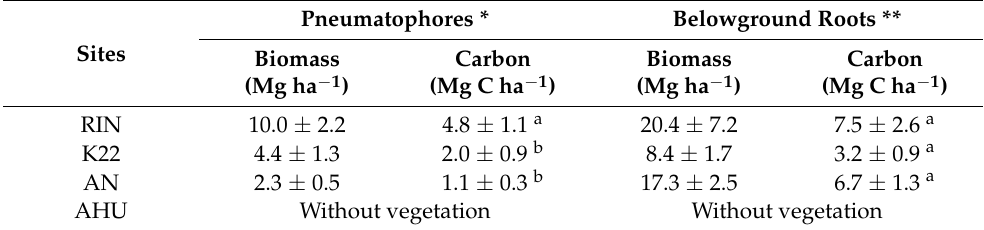
* Plots of 25 × 25 cm. RIN: N = 5. K22 and AN: N = 10. ** Cores of 1 m depth. RIN: N = 5. K22 and AN: N = 10. Different letters represent significant differences among